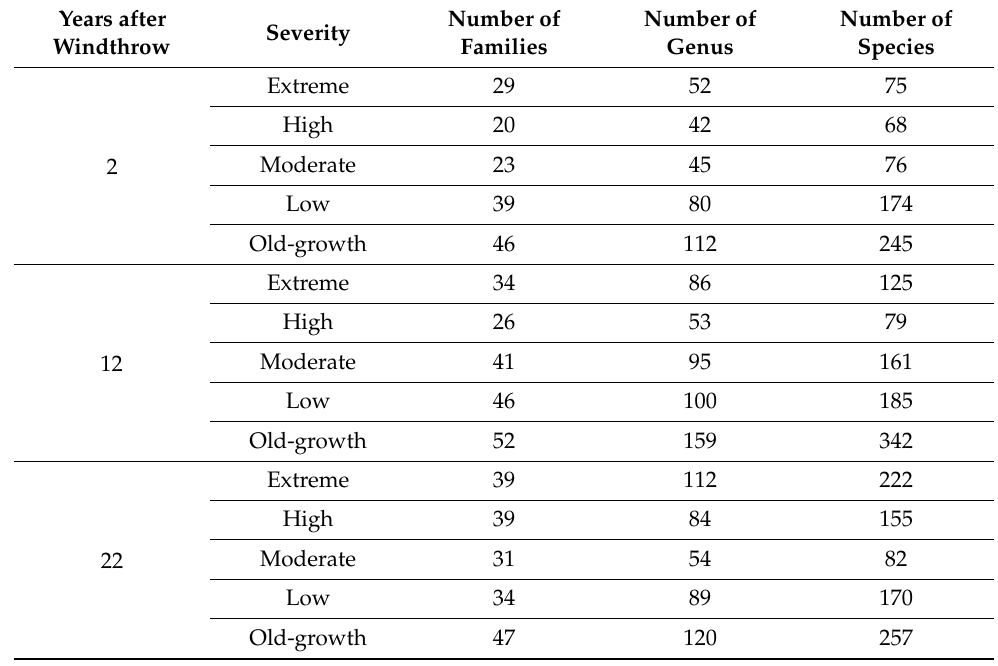
Table A1. Summary of forest floristics characteristic by severity and years after windthrows.